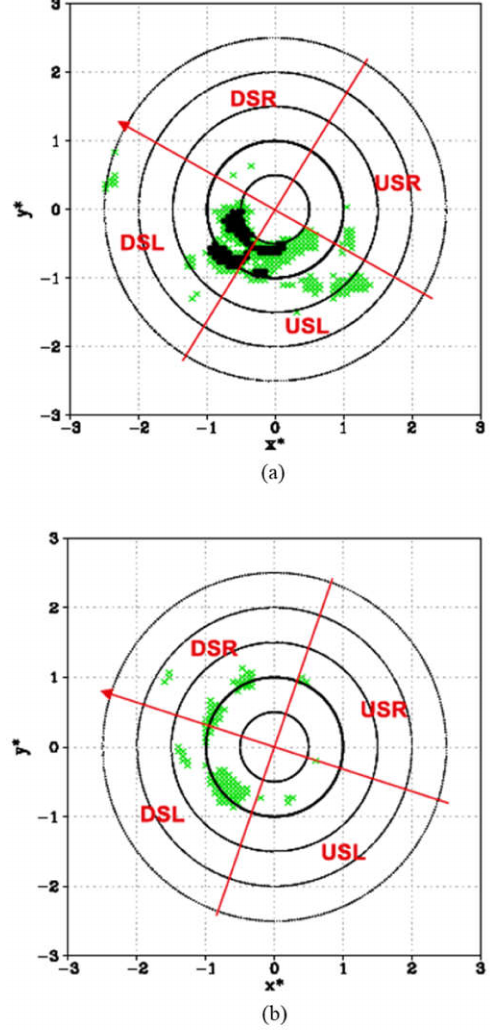
Figure 8. ( a ) Locations of all points in Doppler analysis in a radial coordinate system normalized by the 2-km RMW (x*, y*) where peak upward motion in the 8–16-km layer is greater than 3 m s − 1 (green × s) and 5 m s − 1 (black dots) for all center passes during the 14 Sep (intensifying) mission. ( b ) As in ( a ), but forthe 16 Sep (steady-state) mission. Arrow denotes shear direction; shear-relative quadrants are labeled. Adapted from Rogers et al. (2016)